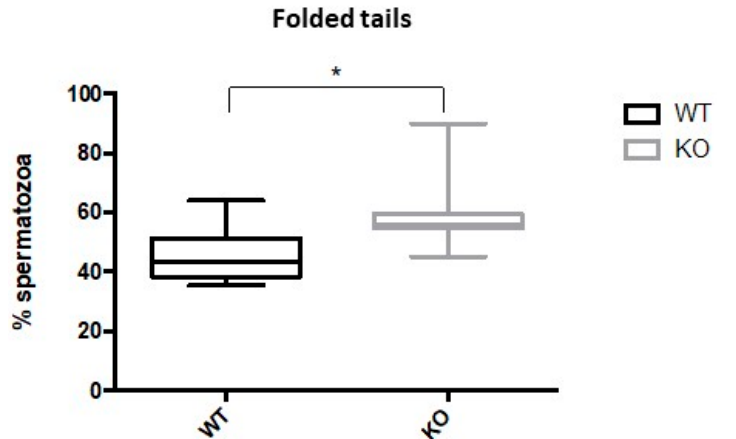
Figure 4. Sperm morphology. WT ( A ) and KO ( B ) mouse sperm observed by phase contrast (Ph2) microscopy. The spermatozoa of both strains of mice displayed normal cell morphology and folded flagella. Folded flagella were more frequent in KO mice. Scale bar in ( A ) and ( B ) = 15 µm. morphology was decreased in Kir5.1 KO (39.6%) mice compared to WT (54.1%) ( p < 0.01). creased in samples collected from Kir5.1 KO mice (60.4%) compared to WT (45.9%) (Figure 5; p value < 0.01).